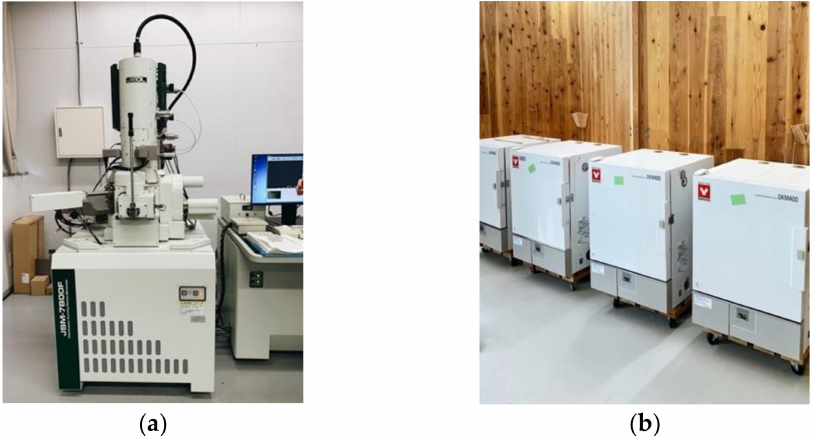
Figure 3. SEM investigation equipment ( a ) FE-SEM JSM-7800F; ( b ) Constant oven